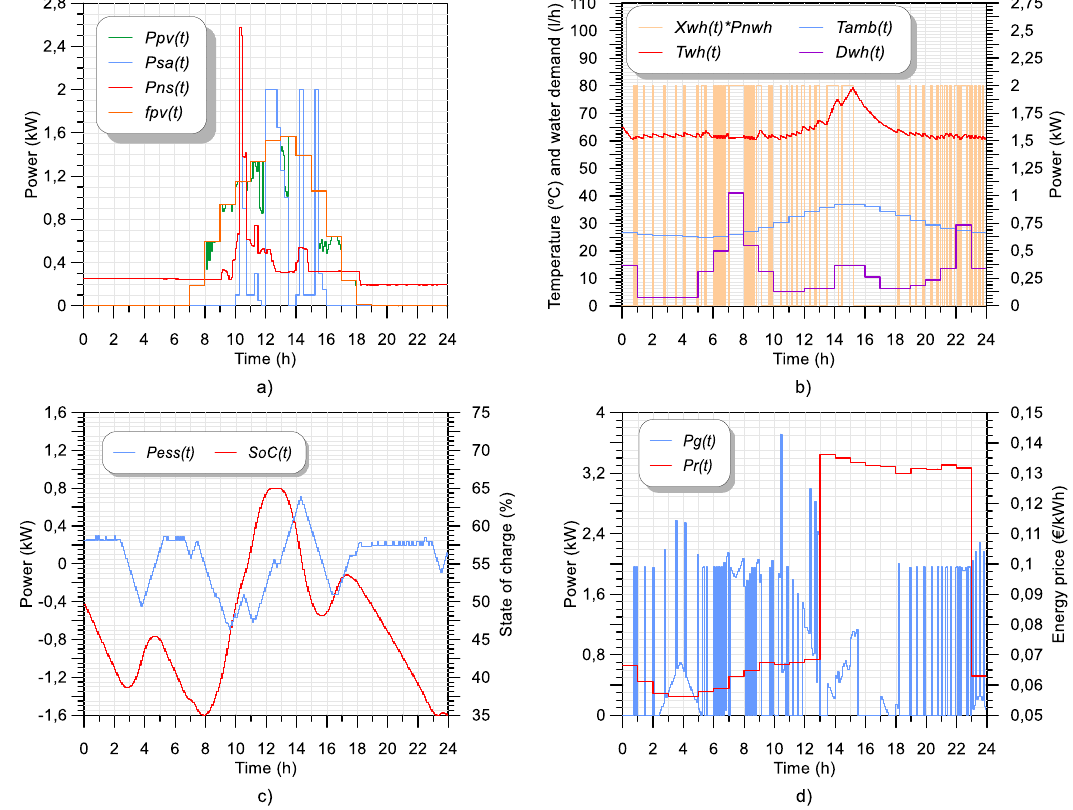
Figure 6. Optimization results using tariff DHA: ( a ) Power injected by the PV system, SA consumption, non-shiftable consumption, and PV production, ( b ) EWH performance: Consumption, ambient and water temperature as well as hot water demand, ( c ) ESS performance: Power and SoC and ( d ) total consumption from the utility and energy prices.